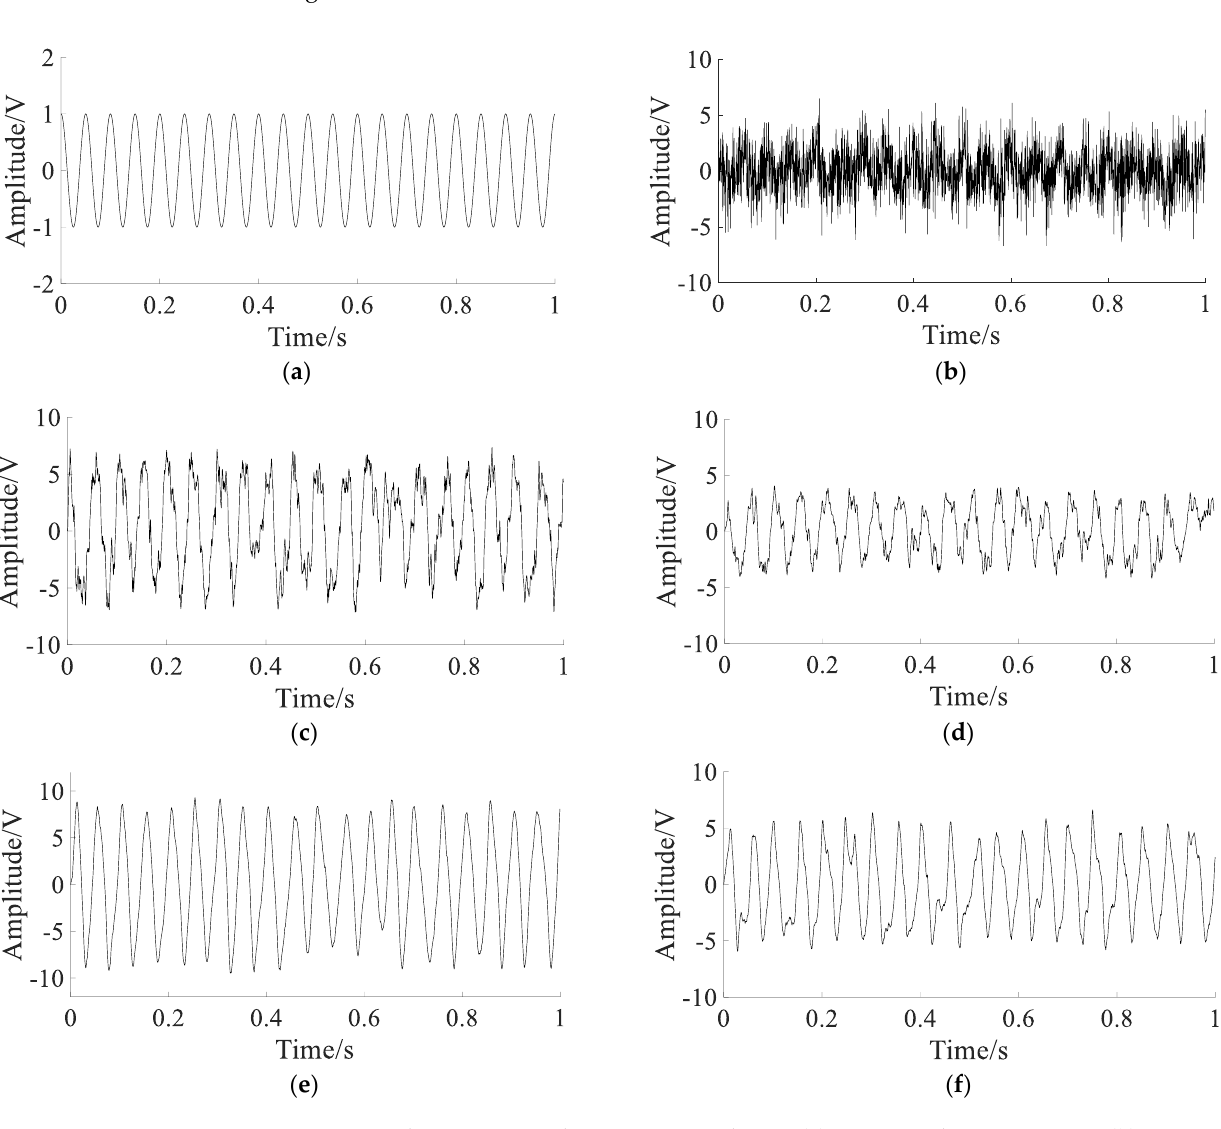
Figure 10. The comparison between CEI and SNR : ( a ) pure signal: CEI = 0.0020; ( b ) noise signal: CEI = 0.4812; ( c ) output signal of SGST adaptive SR based on SNR : a = 0.0248, b = 0.0067, γ = 2.3749, CEI = 0.1021; ( d ) output signal of SGST adaptive SR based on CEI: a = 0.0168, b = 0.0382, γ = 2.1070, CEI = 0.1187; ( e ) output signal of SAFRM adaptive SR based on SNR : γ = 0.05, ε = 0.13, CEI = 0.0568; ( f ) output signal of SAFRM adaptive SR based on CEI: γ = 0.13, ε = 0.16, CEI =